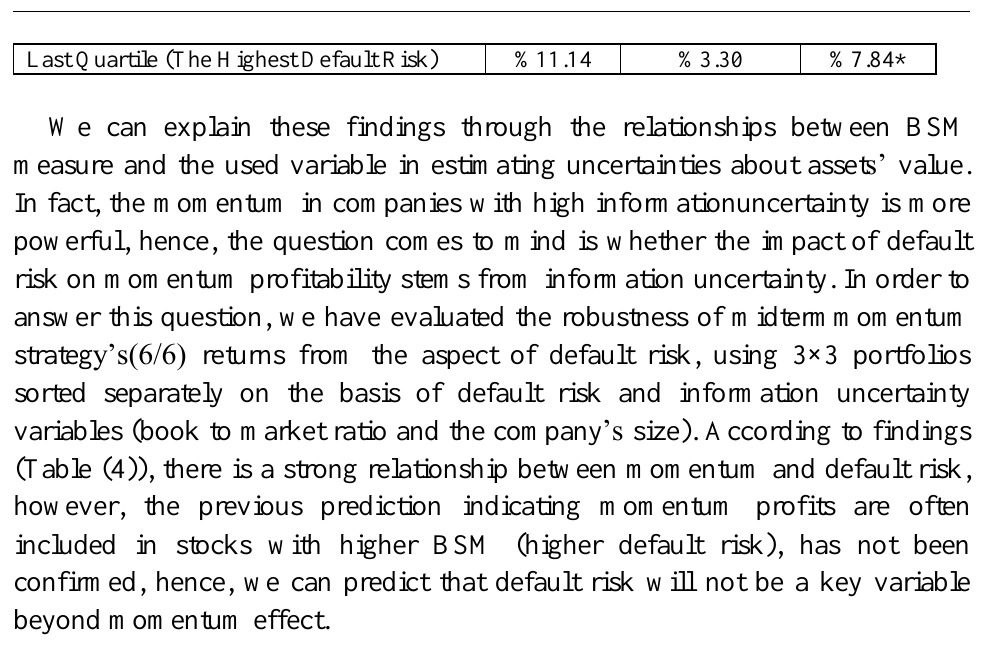
Table (4): IndependentSorting on the Basis of Default Risk and Companies’